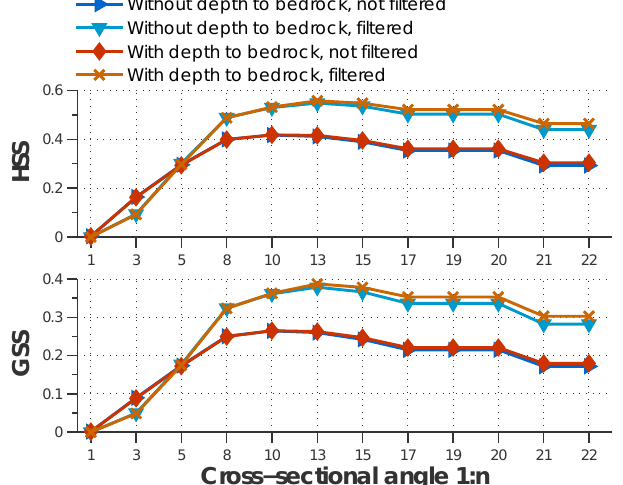
Figure 8. Heidke skill score and Gilbert skill score of the areas prone to landslides obtained with or without the depth to bedrock data and with or without filtering. The effect of the depth to bedrock data and the filtering is shown for several values of the cross- sectional angle threshold (i.e., from 1 : 1 to 1 : 22).